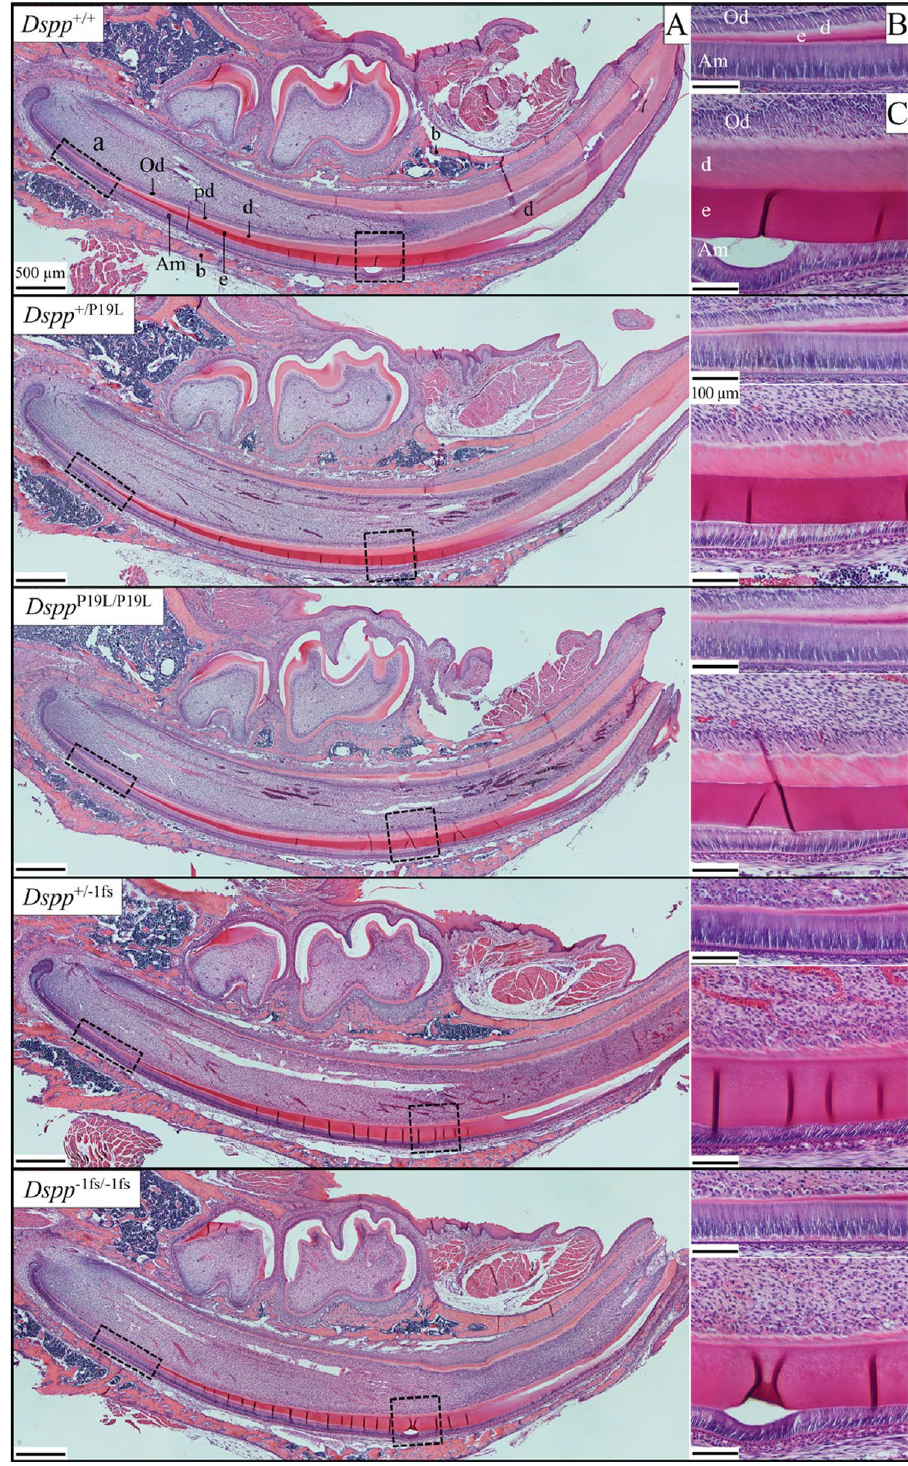
Figure 4. H&E staining of D14 Mandibular Incisors from Dspp +/+ , Dspp +/P19L , Dspp P19L/P19L , Dspp +/−1fs and Dspp −1fs/−1fs Mice. ( A ) Longitudinal hemi-mandible sections with boxes showing the positions of higher magnification images in ( B ) and ( C ). ( B,C ) Note the irregular dentin mineralization front (at the predentin- dentin border) and uneven staining of the modestly thinner dentin layer in Dspp P19L incisors, and odontoblast dysplasia, irregular dentin mineralization front, and very thin dentin in the Dspp −1fs incisors. Key: Am ameloblasts, b bone, d dentin, e enamel, Od odontoblasts, p predentin. Scale bars in ( A ) 500 µm, in ( B,C ) 100